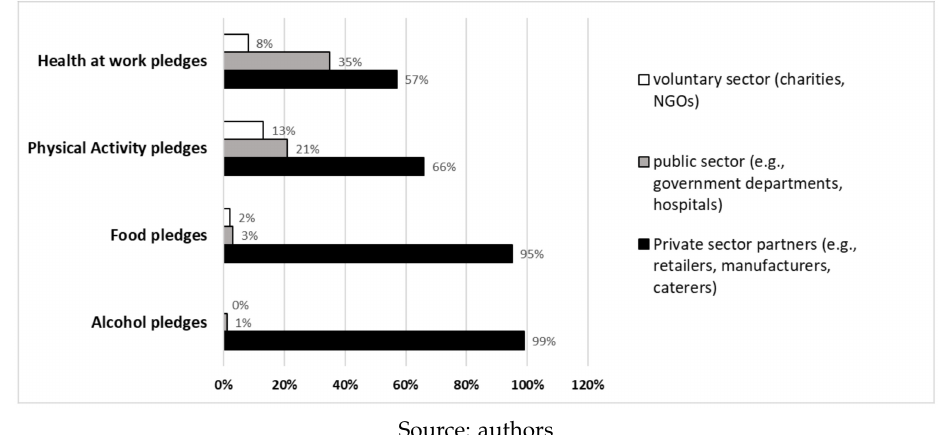
Figure 5. Distribution of RD partners by